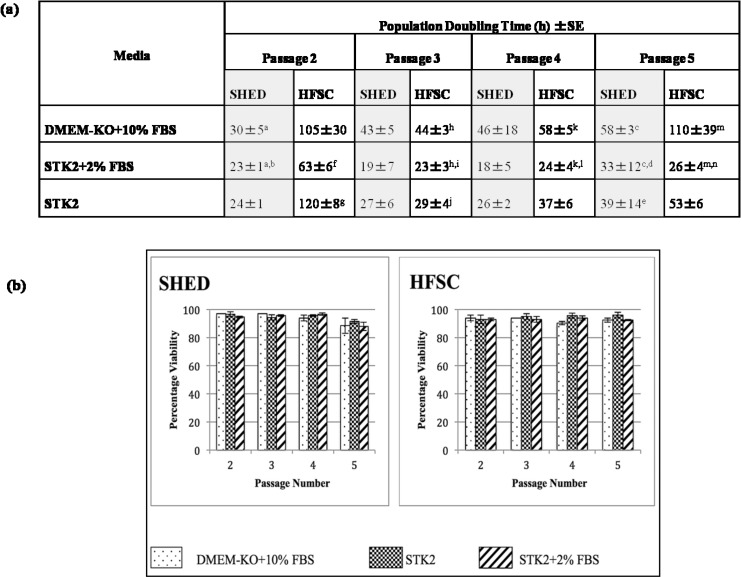
The population doubling times and viability of SHED and HFSCs cultured in the different media combinations from passage 2 to passage 5.(a) The population doubling times of SHED and HFSCs cultured in the different media combinations from passage 2 to passage 5. *The same alphabet indicates a significant difference (p<0.05). There was no statistically significant difference between the population doubling times between SHED and HFSC. (b)The percentage of viability of SHED and HFSCs cultured in media combinations; DMEM-KO+10% FBS, STK2+2% FBS and STK2 from passages 2 to 5.